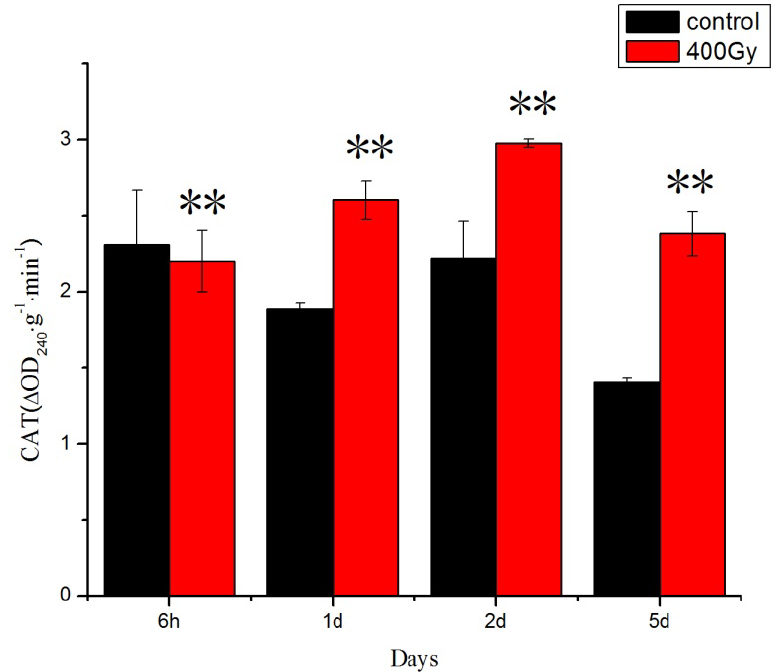
Figure 2. Effects of 60 Co- γ irradiation on CAT activity of P. citri adults for different lengths of time. Values are mean ± SD ( n = 3). Asterisk designates statistically significant difference between control and irradiated adults (** p <